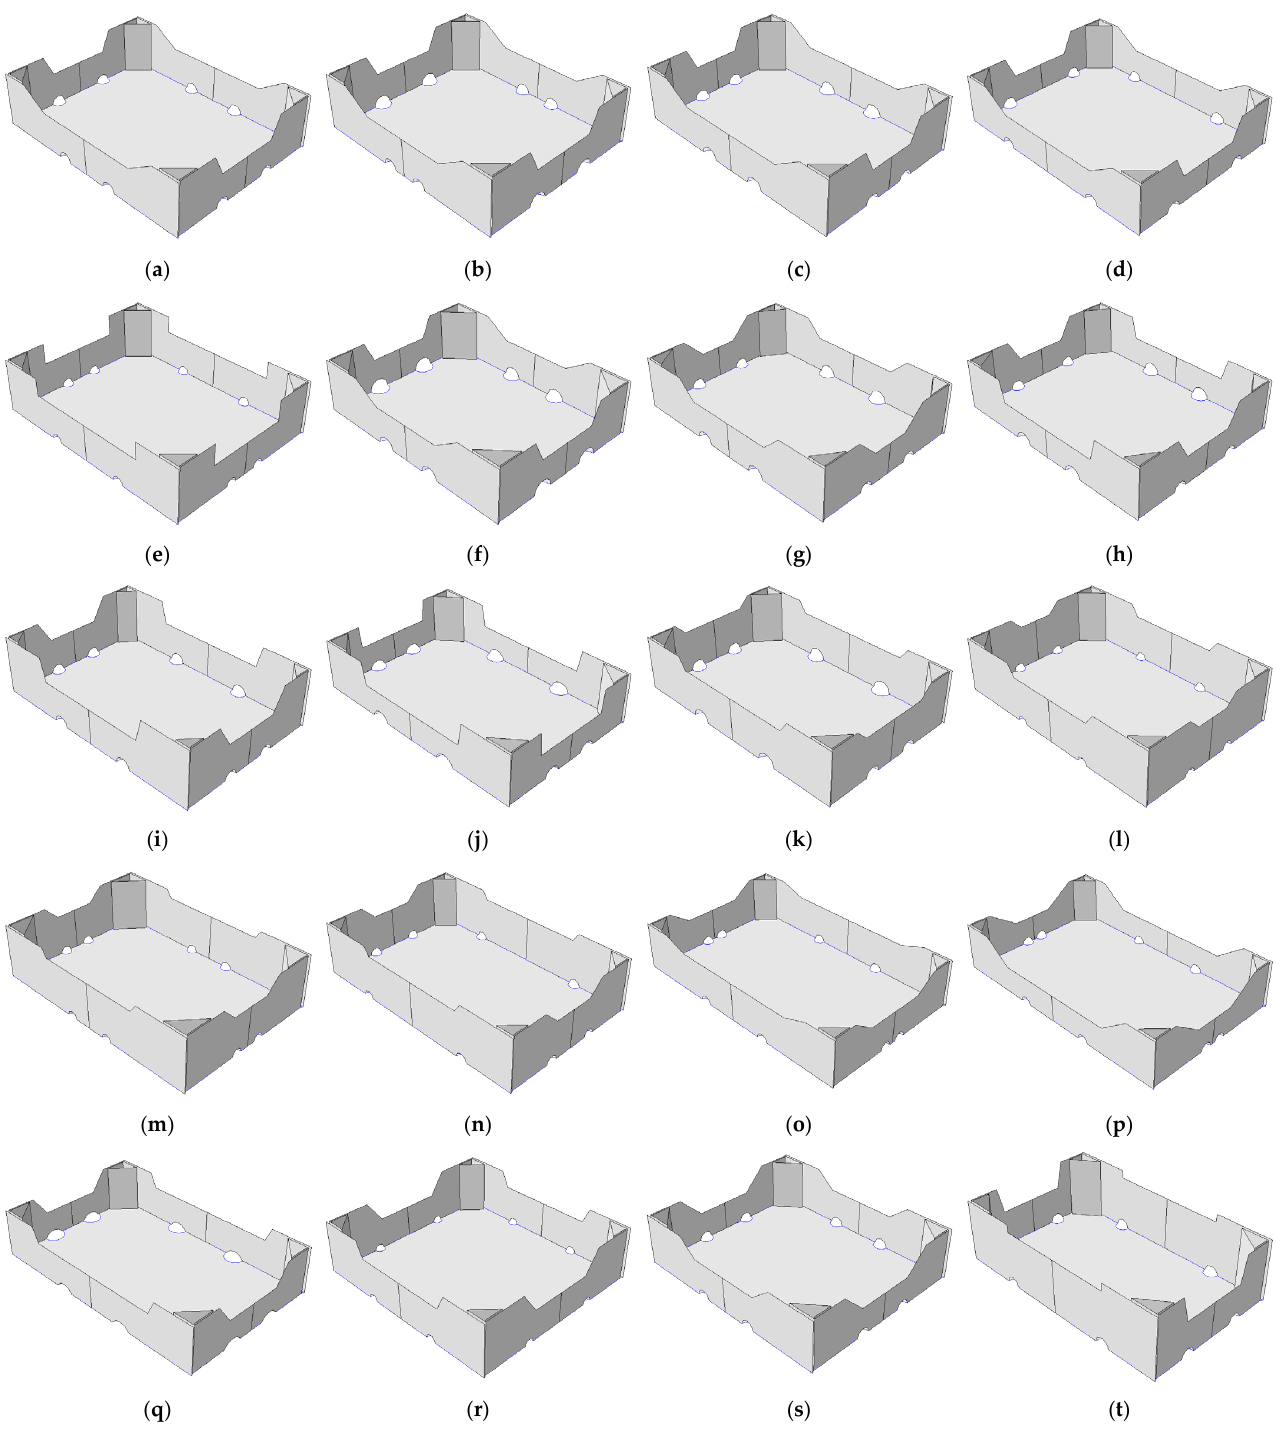
Figure 3. Cases of selected open-top boxes for the storage of